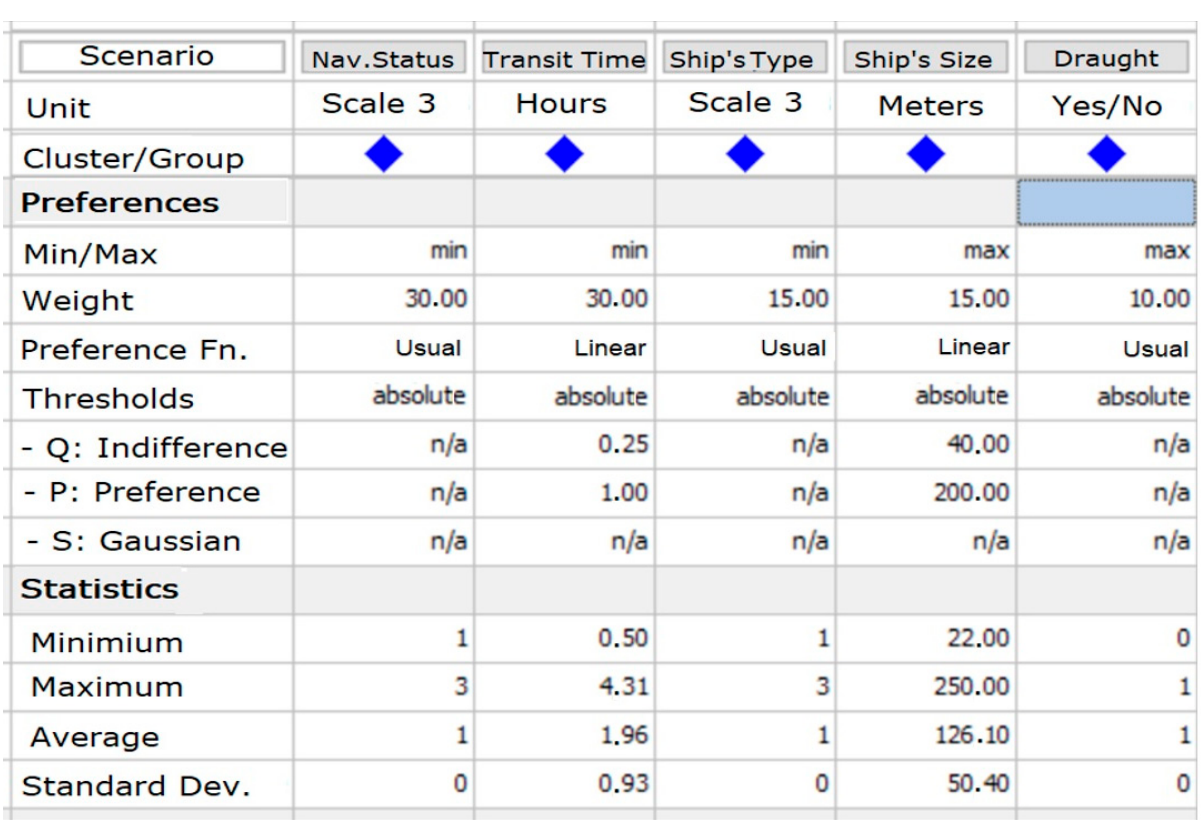
Figure 7. Visual Promethee software dialogue window: criterion weight, preference function, preference threshold for the defined set of criteria (own work on the basis of the Visual Promethee software).